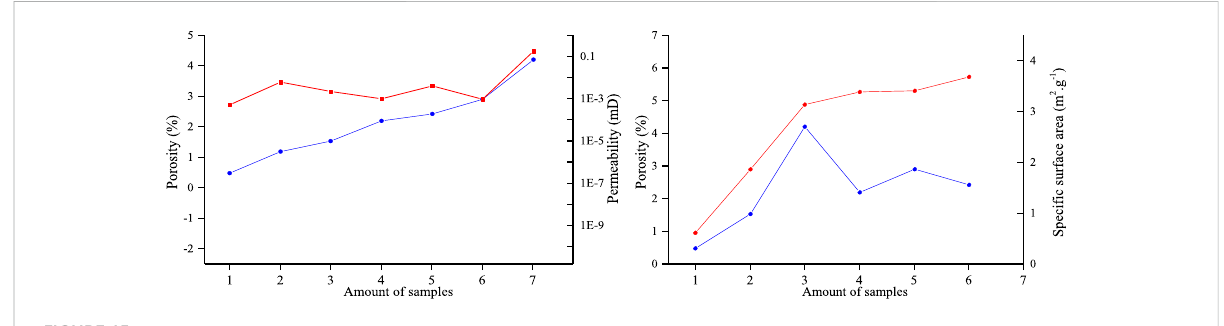
FIGURE 15 Change in the porosity and permeability of the sandstone sample in the upper section. The blue line is porosity and red line is permeability.